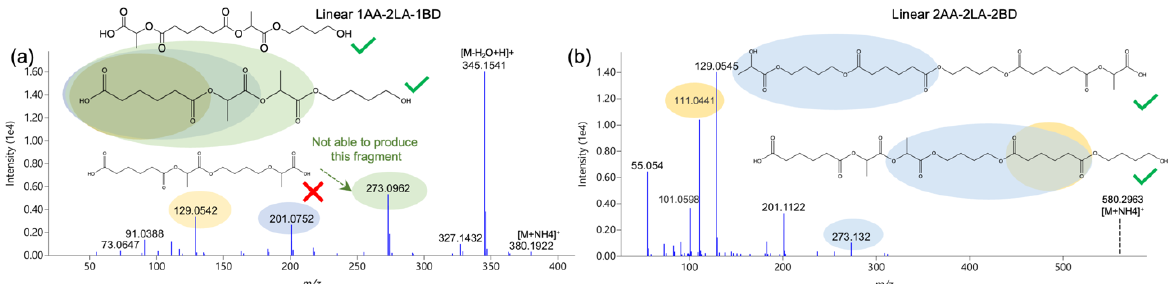
Figure 5. Representative spectra of PBAT oligomer derivatives. ( a ) Linear 1AA-2LA-1BD; ( b ) Linear 2AA-2LA-2BD.